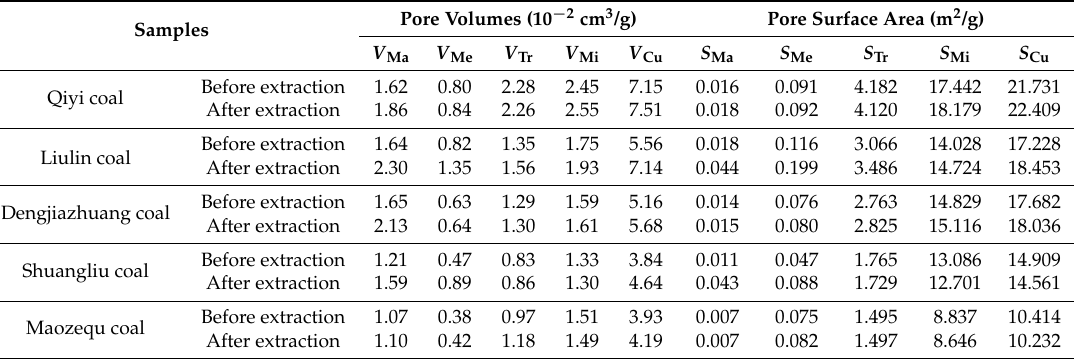
Table 2. Pore volumes and surface areas of the samples before and after the Sc-CO 2 extraction.